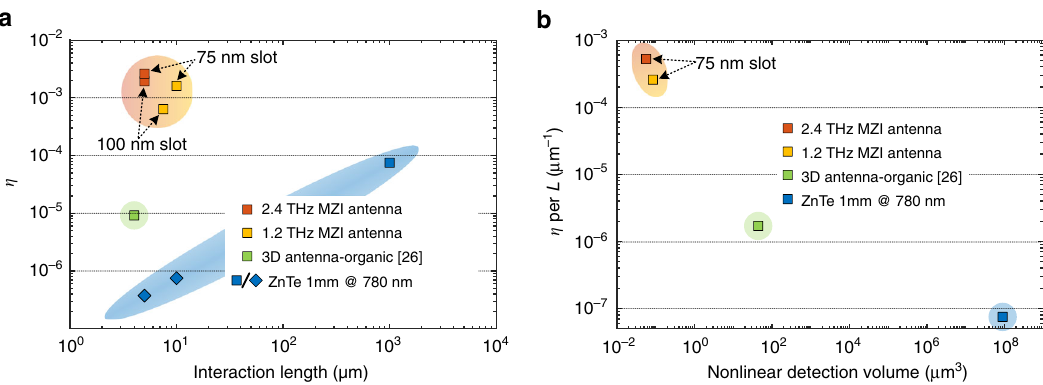
Fig. 4 On-chip detector performance. a The modulation ef fi ciency as a function of the nonlinear interaction length is presented for several devices (with a slot width of the PPS of 75 or 100 nm, respectively). For comparison, we show the modulation ef fi ciency of the 3D antenna and a ZnTe crystal of 1 mm length. The rhombus shapes represent extrapolated values from the detection ef fi ciency at 1 mm length. b The modulation ef fi ciency per unit length of interaction distance is represented as a function of the nonlinear detection volume in the different